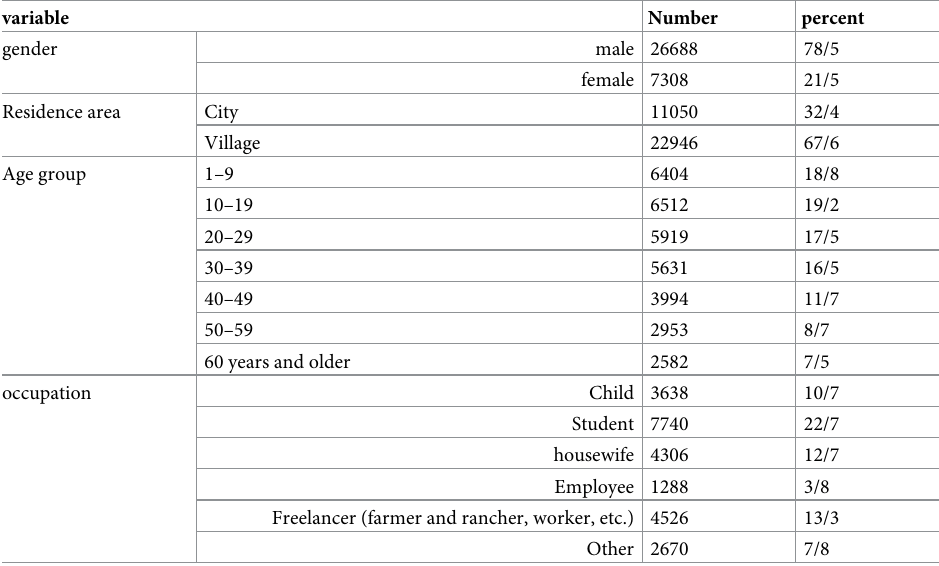
Table 1. Demographic information of the selected bitten animal patients.